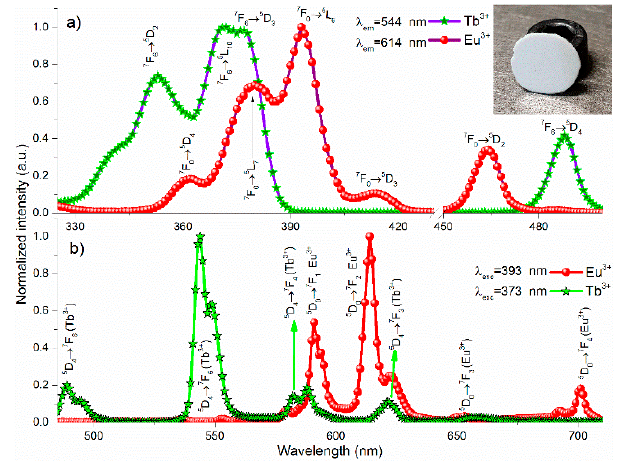
Figure 2. ( a ) Excitation and ( b ) emission spectra for Eu 3 + - and Tb 3 + -doped samples. The inset shows the picture of the opaque ceramic phosphor